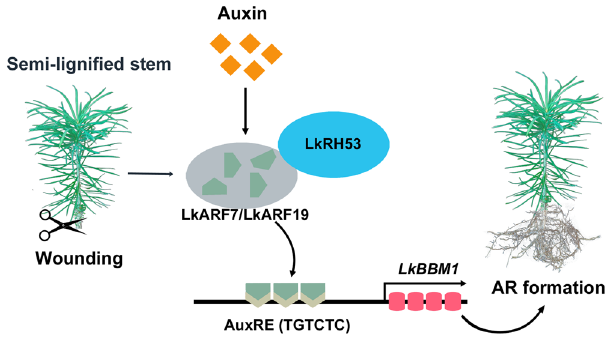
Fig. 7 A proposed model of the role of LkARF7 and LkARF19 in AR formation. The expression of LkARF7 and LkARF19 increases after the semi- ligni fi ed stem is cutoff. Auxin also promotes the expression of LkARF7 and LkARF19 . LkARF7 and LkARF19 bind to AuxREs and promote LkBBM1 transcription to regulate AR formation. In addition, LkARF19 interacts with LkRH53 to form heterodimers to regulate AR